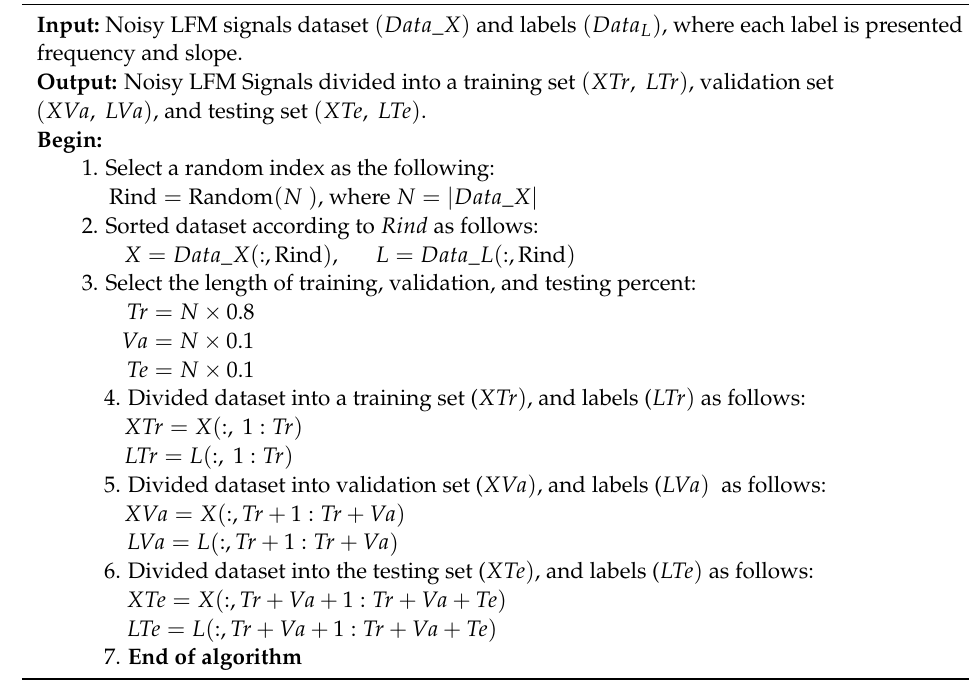
Algorithm 2: The Dataset is Divided into Training, Validation, and Testing